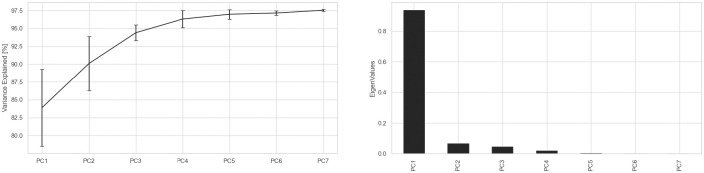
Illustrations of both the percentage of variance explained (left) and Eigenvalues (right) for each PMk.